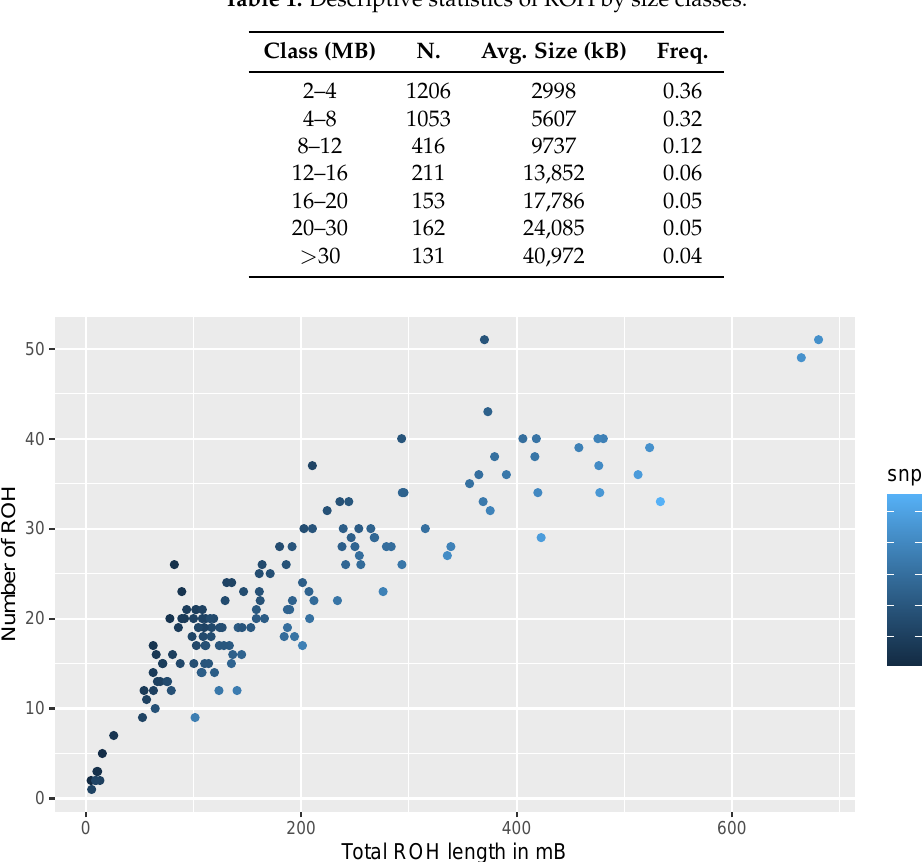
Table 1. Descriptive statistics of ROH by size classes.